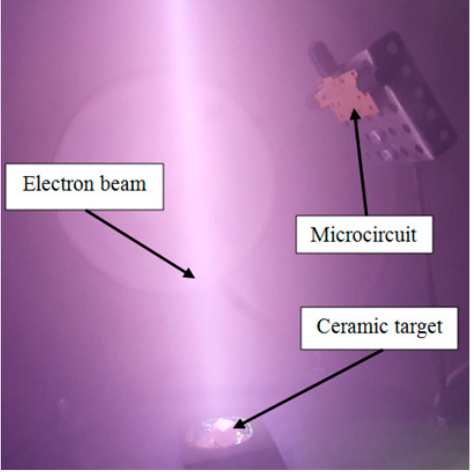
Figure 2. The process of electron-beam coating deposition on a MIC sample.